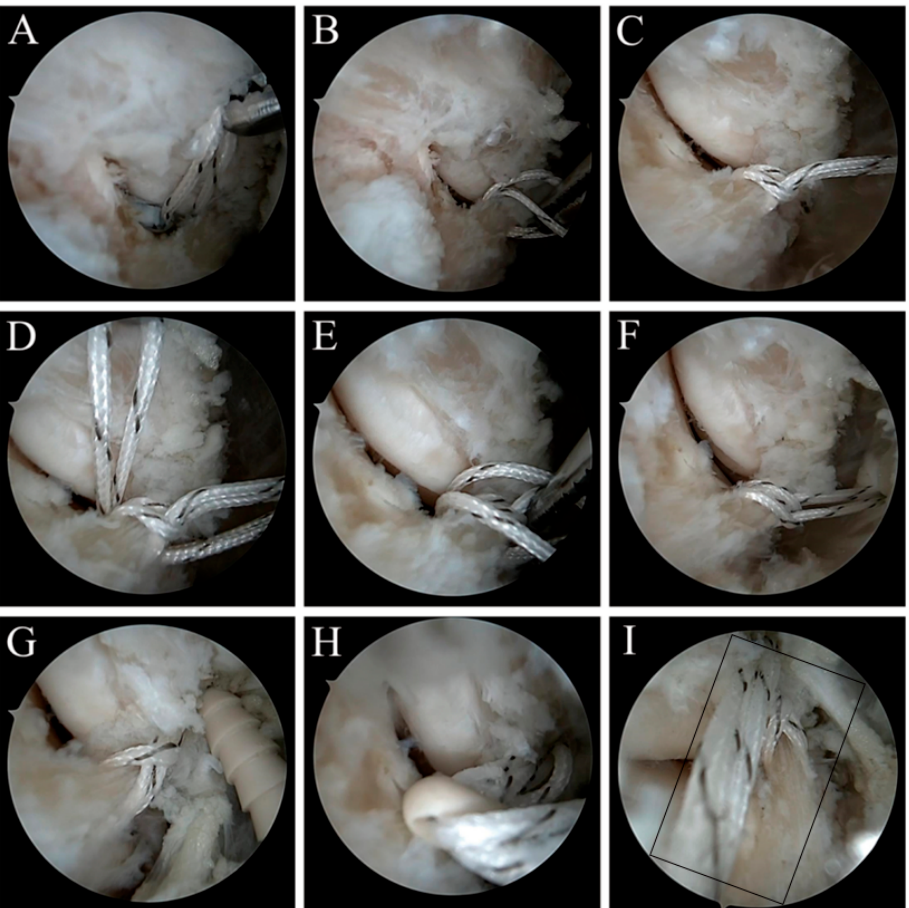
Figure 3. ATFL plus suture augmentation repair under total arthroscopy. ( A ): Line crossing and line grasping. ( B , C ): Ring sleeve. ( D – F ): Line crossing, line grasping and ring sleeve around the ATFL again. ( G ): The fibula side was implanted with knotless anchor. ( H ): The talus side was implanted with knotless anchor. ( I ): Postoperative effect.